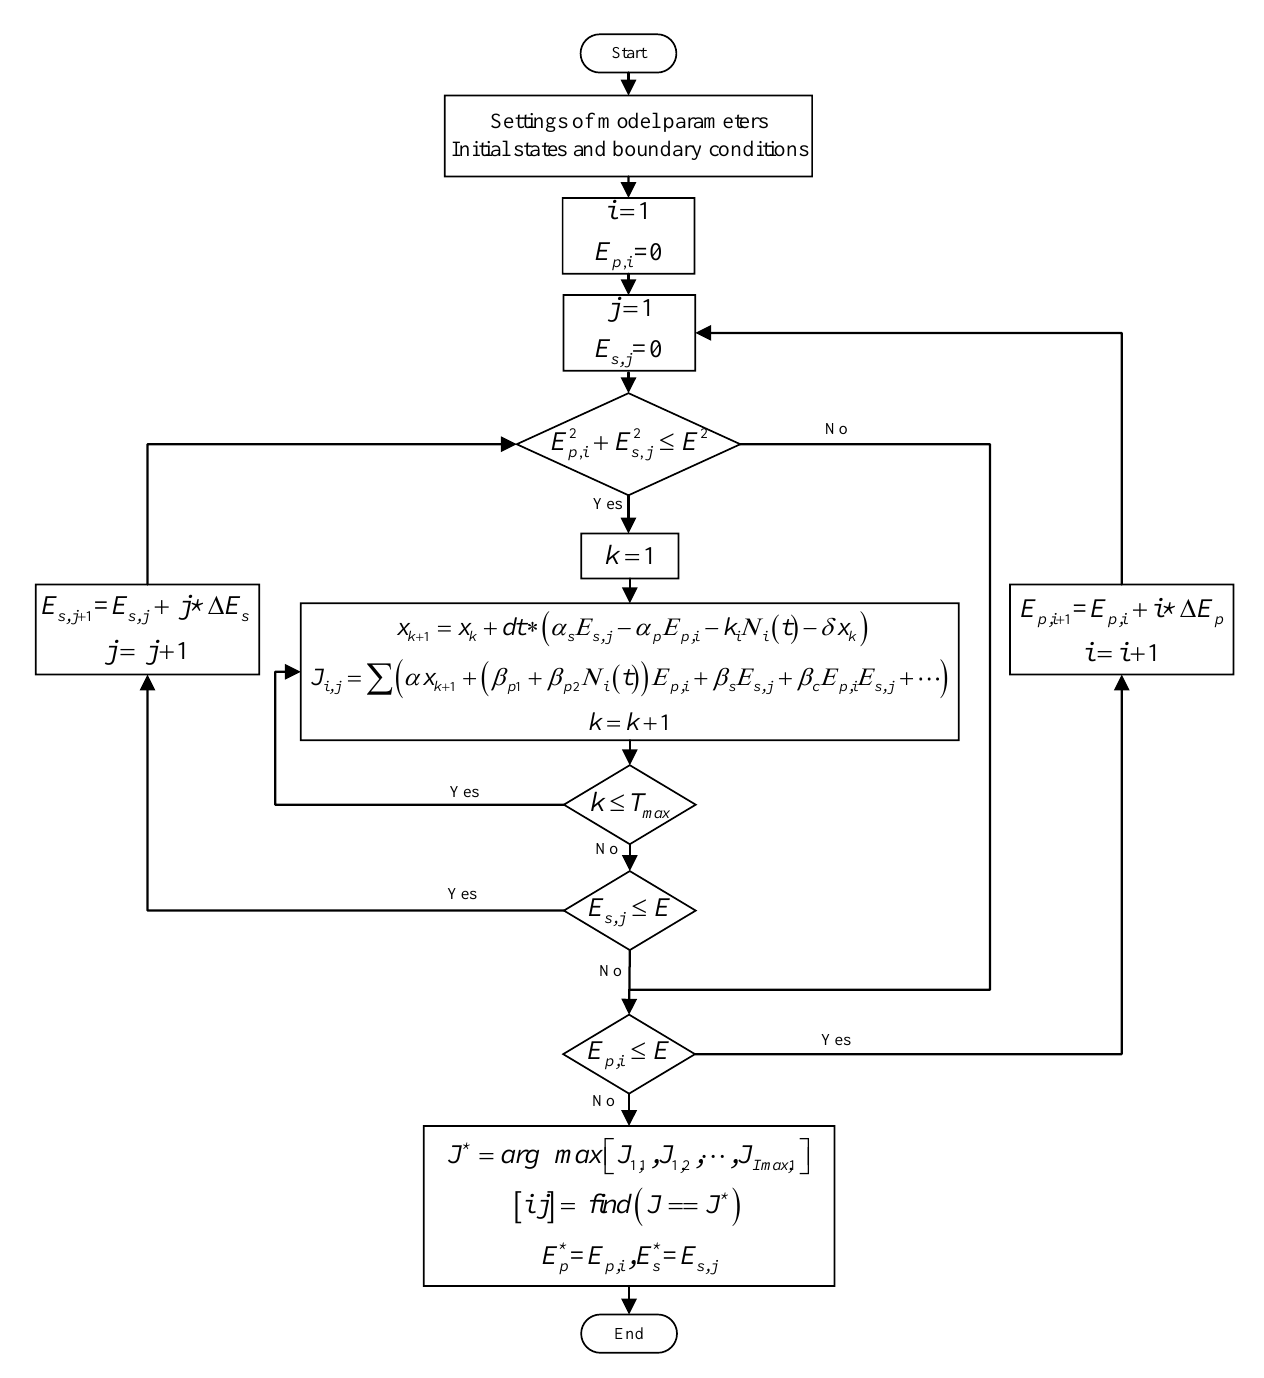
Figure 1. Algorithmic flowchart of the static strategy.